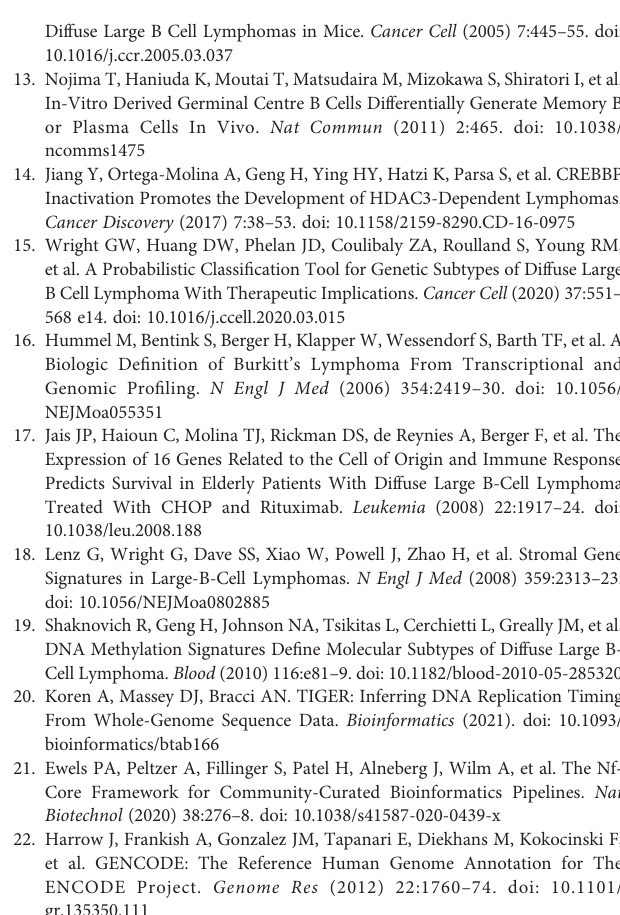
cytometry in B cells, germinal centers, centroblasts, and centrocytes. (B) Freshly isolated resting B cells (control) and 90 Gy irradiated resting B cells (irradiated) were stained with anti- g H2AX antibodies and analyzed by FACS. Averages of percent positivity for g H2AX control and irradiated are shown in the plot below. (C) Scheme depicting the induced GC B cell culture system. (D) Representative karyotype arrangement produced from iGC B cells. Supplementary Figure 5 | Copy number and replication fork usage analysis in primary Smc3 haploinsuf fi cient germinal center B cells. (A) DNA copy number for mouse chromosomes 1 to 19 and ChrX in Smc3 wt/wt (upper plot), Smc3 wt/ – (middle plot), and the difference (lower plot). (B) DNA replication timing for Chr 2 calculated by assessing the DNA copy number along the whole chromosome for Smc3 wt/wt (blue line) and Smc3 wt/ – (green line). Supplementary Figure 6 | Decreased cohesin levels predict poor survival in DLBCL patients. (A) Dendrogram showing assignment of patients from the BCCA cohort to clusters 1 and 2, de fi ned by unsupervised hierarchical clustering using the Smc3 haploinsuf fi cient gene signature. (B) Expression levels of cohesin core subunits in cluster 1 and cluster 2 in the BCCA cohort. (C) Kaplan-Meier overall survival curves for ABC-subtype DLBCL patients (n=108) in BCCA cohort clustered with the Smc3 haploinsuf fi cient signature (6). (D) Kaplan-Meier progression-free survival curves for ABC-subtype DLBCL patients (n=108) in BCCA cohort clustered with the Smc3 haploinsuf fi cient signature (6). (E) Dendrogram showing assignment of patients from the NCI cohort to clusters 1 and 2, de fi ned by unsupervised hierarchical clustering using the Smc3 haploinsuf fi cient gene signature. (F) Expression levels of cohesin core subunits in cluster 1 and cluster 2 in the NCI cohort. (G) Kaplan-Meier overall survival curves for DLBCL patients (n=243) in NCI cohort clustered with the Smc3 haploinsuf fi cient gene signature